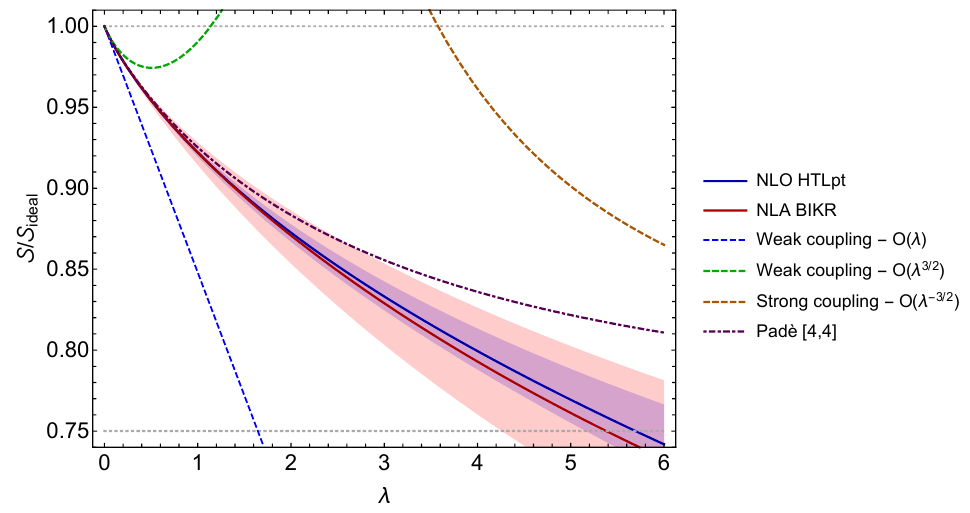
Figure 6 . Comparison of our NLO HTLpt result for the scaled entropy density with the prior NLA work of Blaizot, Iancu, Kraemmer, and Rebhan (BIKR) [5]. A detailed description of the various lines can be found in the text.